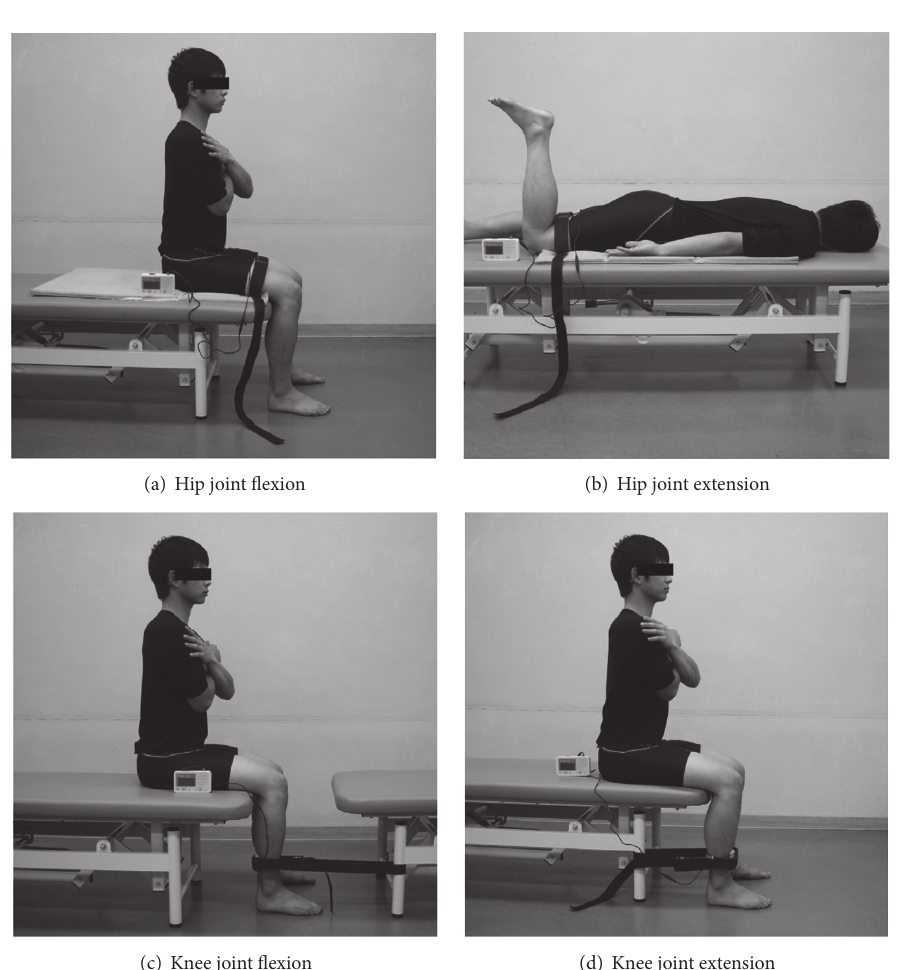
Figure 1: Measurement